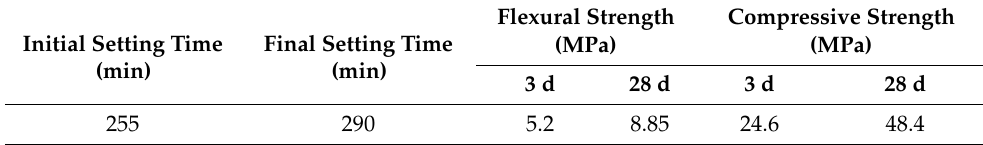
Table 1. The performance indexes of cement.